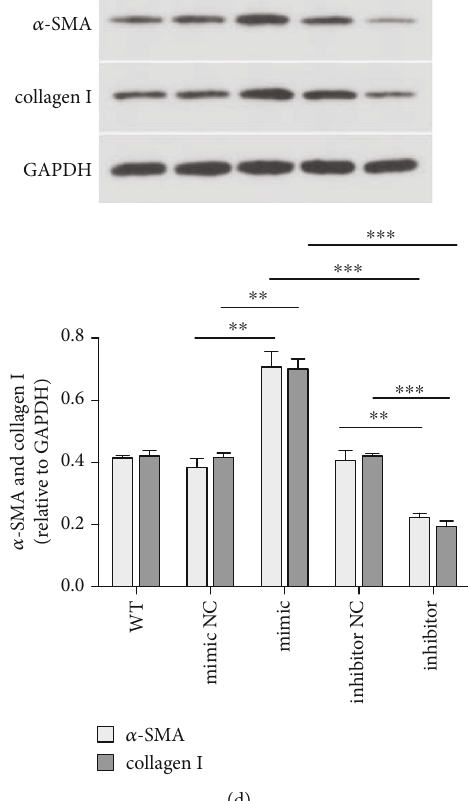
Figure 5: miR-34a induced EMT and fi brogenesis of HIBEC. (a) Vimentin and FSP-1 mRNA levels (for vimentin, miR-34a mimics vs. NC, P < 0 : 0001 ∗∗∗ ; miR-34a mimics vs. inhibitor, P < 0 : 0001 ∗∗∗ , and miR-34a inhibitor vs. NC, P < 0 : 0001 ∗∗∗ ; for FSP-1, miR-34a mimics vs. NC, P < 0 : 0001 ∗∗∗ ; miR-34a mimic vs. inhibitor, P < 0 : 0001 ∗∗∗ ; and miR-34a inhibitor vs. NC, P < 0 : 0001 ∗∗∗ ). (b) α -SMA and collagen I mRNA levels (for α -SMA, miR-34a mimics vs. NC, P < 0 : 0001 ∗∗∗ ; miR-34a mimics vs. inhibitor, P < 0 : 0001 ∗∗∗ ; and miR-34a inhibitor vs. NC, P < 0 : 0001 ∗∗∗ ; for collagen I, miR-34a mimics vs. NC, P < 0 : 0001 ∗∗∗ ; miR-34a mimics vs. inhibitor, P < 0 : 0001 ∗∗∗ ; and miR-34a inhibitor vs. NC, P < 0 : 0001 ∗∗∗ ). (c) Relative vimentin and FSP-1 protein expressions (for vimentin, miR-34a mimics vs. NC, P = 0 : 0031 ∗∗ ; miR- 34a mimics vs. inhibitor, P = 0 : 0003 ∗∗∗ ; and miR-34a inhibitor vs. NC, P = 0 : 0015 ∗∗ ; for FSP-1, miR-34a mimics vs. NC, P = 0 : 0054 ∗∗ ; miR-34a mimics vs. inhibitor, P = 0 : 0004 ∗∗∗ ; and miR-34a inhibitor vs. NC, P = 0 : 0271 ∗ ). (d) Relative α -SMA and collagen I protein expressions (for α -SMA, miR-34a mimics vs. NC, P = 0 : 0047 ∗∗ ; miR-34a mimics vs. inhibitor, P = 0 : 0007 ∗∗∗ ; and miR-34a inhibitor vs. NC, P = 0 : 0083 ∗∗ ; for collagen I, miR-34a mimics vs. NC, P = 0 : 0023 ∗∗ ; miR-34a mimics vs. inhibitor, P = 0 : 0003 ∗∗∗ , and miR-34a inhibitor vs. NC, P = 0 : 0006 ∗∗∗